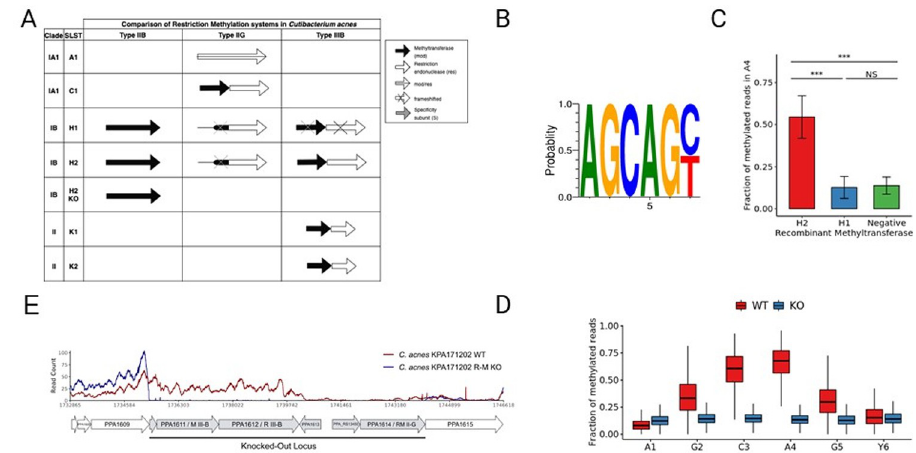
Fig 1. C . acnes KPA171202 (SLST H2) has a functional R-M system with a methylation motif in the AGCAGY sequence. - (A) Genomic comparison of potential R-M systems in selected C . acnes strains using assemblies available in REBASE and comparing strain or clade level. Black represents the MTase while white represents the REase. (B) Sequence logo of the methylation motif from the reads with highest methylation score. (C) Fraction of methylated reads in the methylated adenine of the AGCAGY motif detected in the pMW535 plasmid after recombinant expression of H1 or H2 IIIB methyltransferase. (D) Fraction of methylated reads across the positions of the AGCAGY motif for the wild-type (red) and the type IIIB R-M system knock-out (blue) KPA171202 (H2) strain. (E) Transcriptional profile of restriction methylation locus and surroundings in C . acnes KPA171202 Wild Type (SLST H2 WT) and C . acnes restriction methylation knock-out (SLST H2 R-M KO). Expression levels are displayed by RNA-seq read counts per genomic position (mean of two replicates). R-M IIG corresponds to PPA1614 and R-M IIIB to PPA1611.